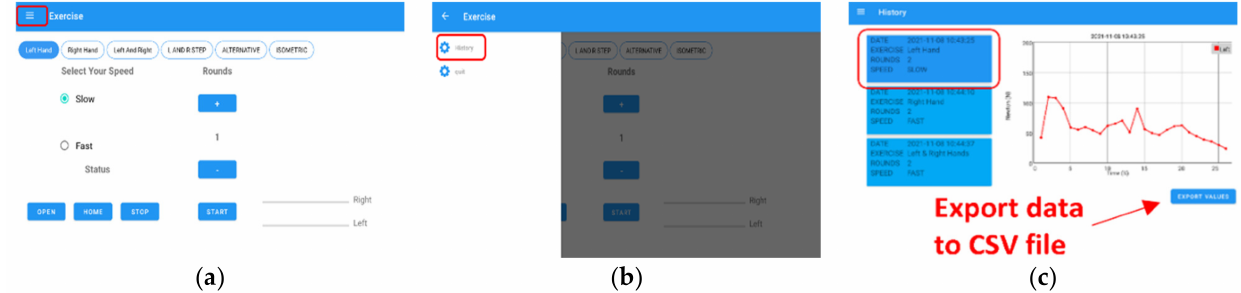
Figure 12. ( a ) First; ( b ) second; (c) third step to access exercise data on the FIT-WHEEL